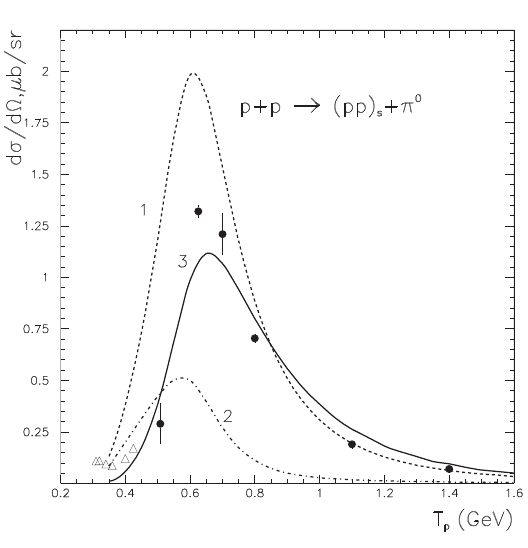
Figure 2. The di ff erential cross section of the reaction pp → { pp } π 0 at zero angle of the s diproton. The lines show results of calculations [12] based on the Δ -mechanism (Fig. 1) for the direct (1), exchange (2) term and their coherent sum(3); experimental data are taken from Ref. [14] ( • ), and Ref. [15] ( (cid:5) ).